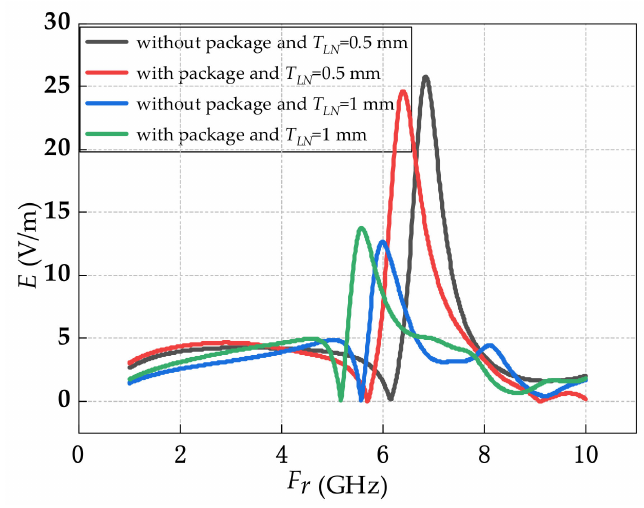
Figure 3. Different structures resonant